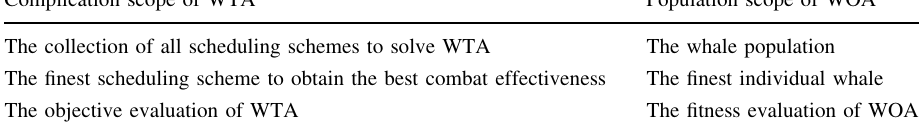
complication scope and population